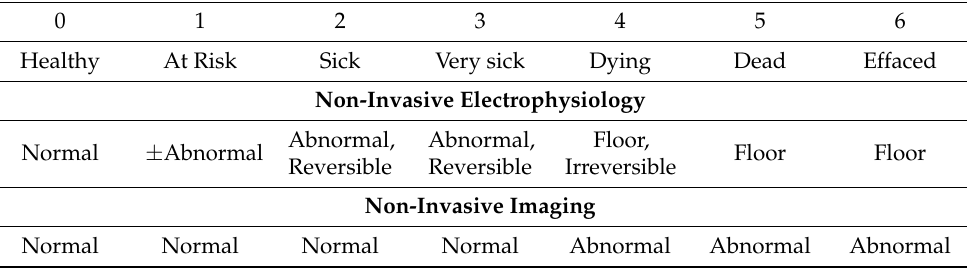
Table 1. Conceptual stages of retinal ganglion cell (RGC) death in glaucoma and optic neuropathies that can be tested with non-invasive electrophysiology such as pattern electroretinogram (PERG) and imaging such as optical coherence tomography (OCT) and scanning laser ophthalmoscopy (SLO) combined with apoptotic